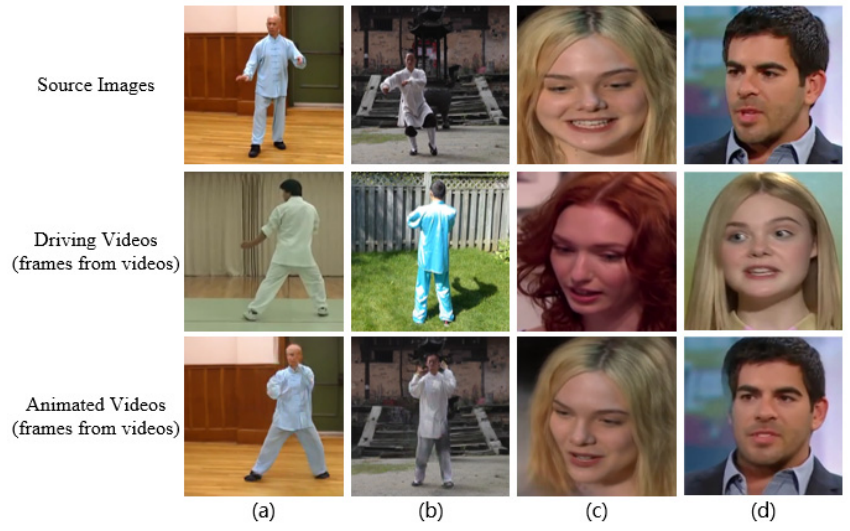
Figure 2. Failure cases of FOMM. ( a ) Frame 1 generated with the incorrect posture. ( b ) Frame 2 generated with the incorrect posture. ( c )Frame 1 generated with ghost effects. ( d ) Frame 2 generated with ghost effects.